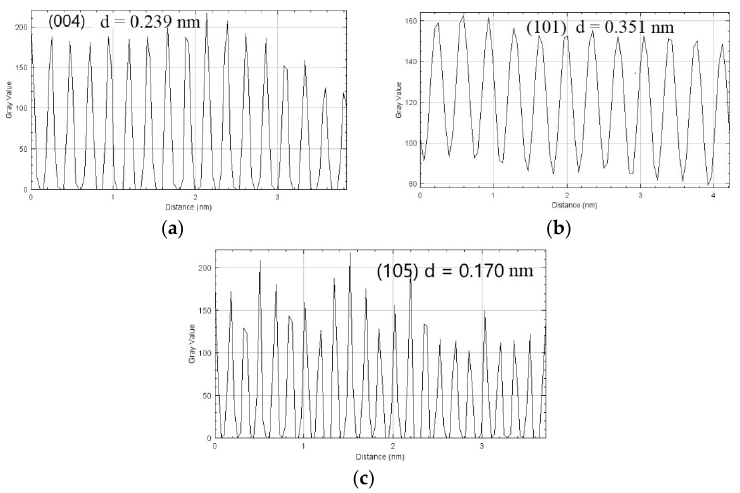
Figure 5. Magnified lattice fringes for d-spacing calculation in ( a ) (004), ( b ) (101), and ( c ) (105) peaks.